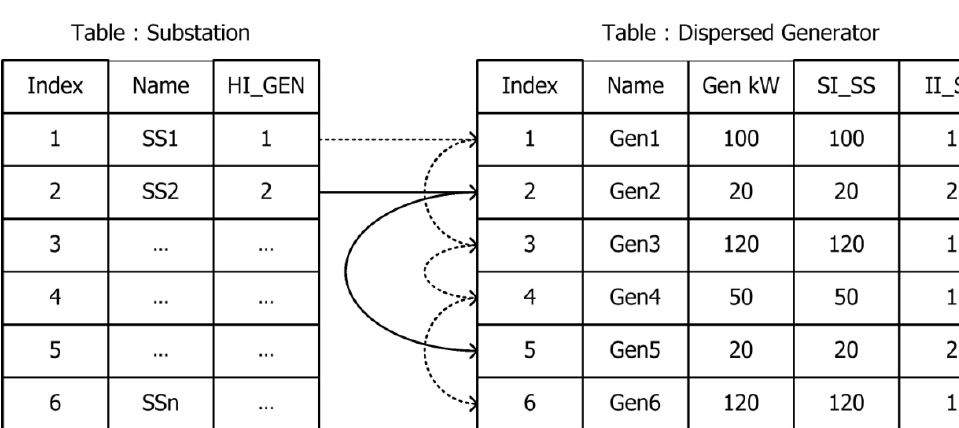
Figure 10. Example of index structured